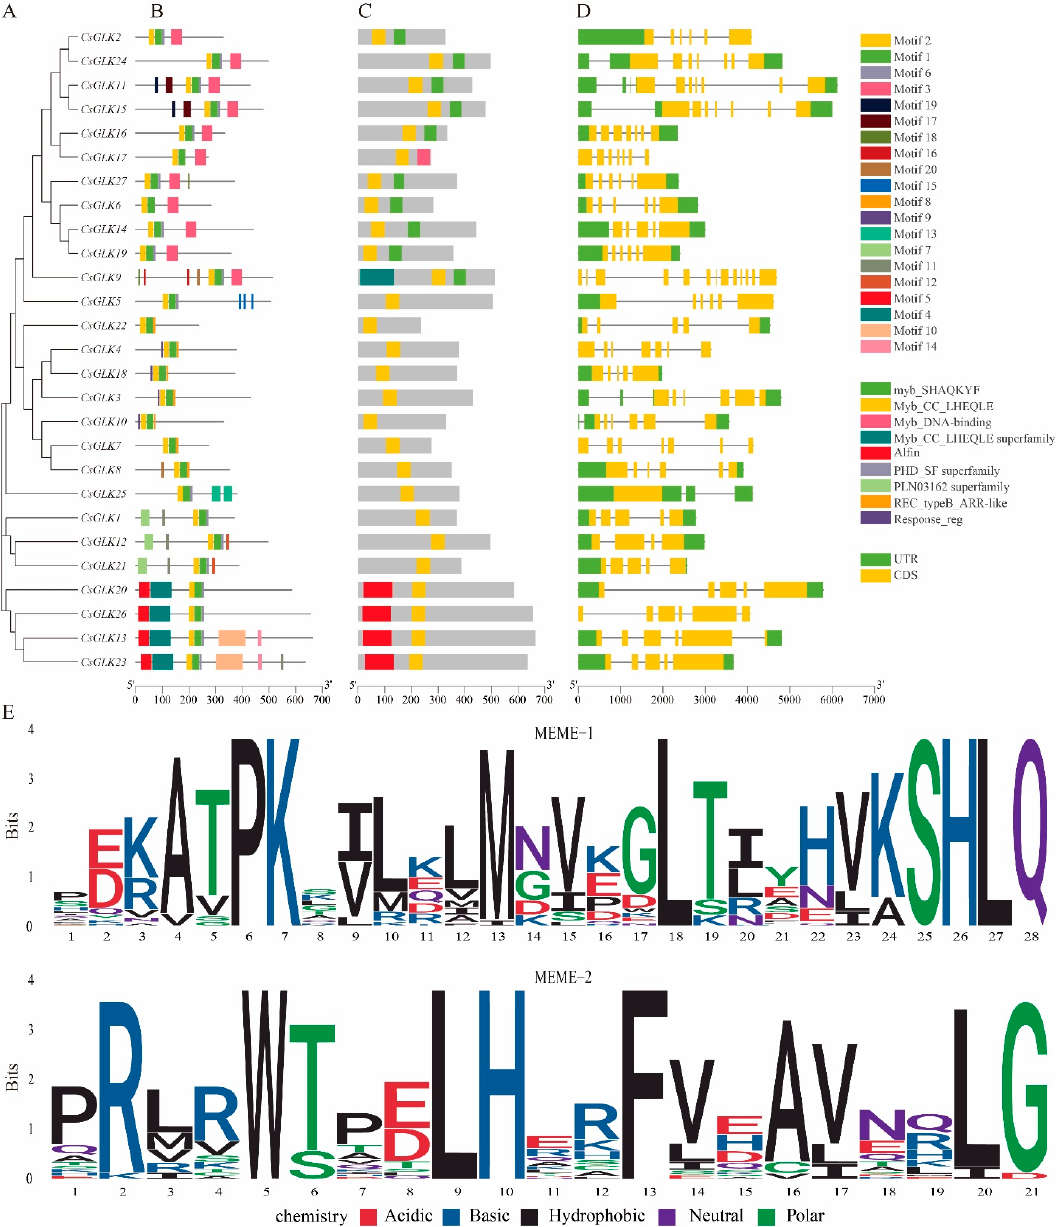
Figure 2. ( A ) Protein phylogeny, ( B ) conserved motif, ( C ) conserved domain, ( D ) gene structure and ( E ) conserved domain sequence. The scale bar at the bottom was used to estimate the sizes of protein structure and gene structure.